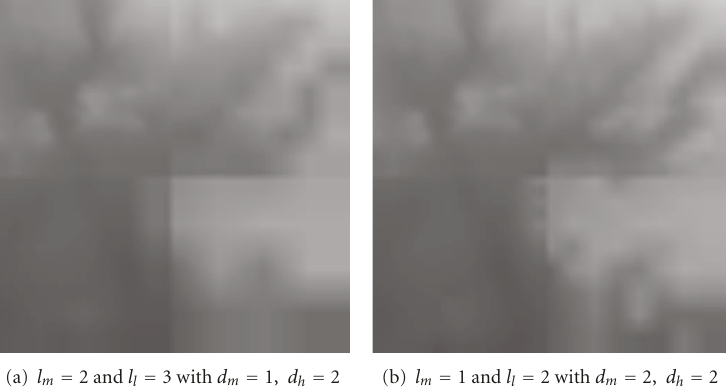
Figure 16: Method I: example DEM tessellation with l h =